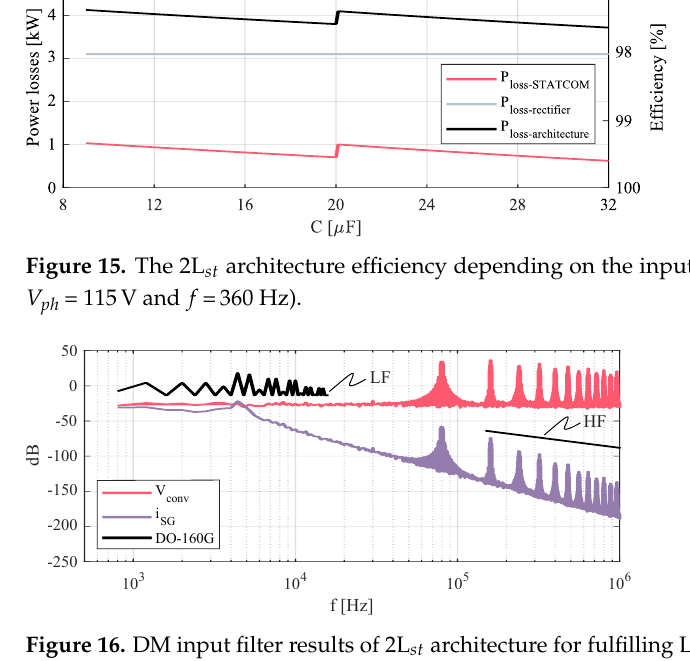
Figure 16. DM input filter results of 2L st architecture for fulfilling LF and HF